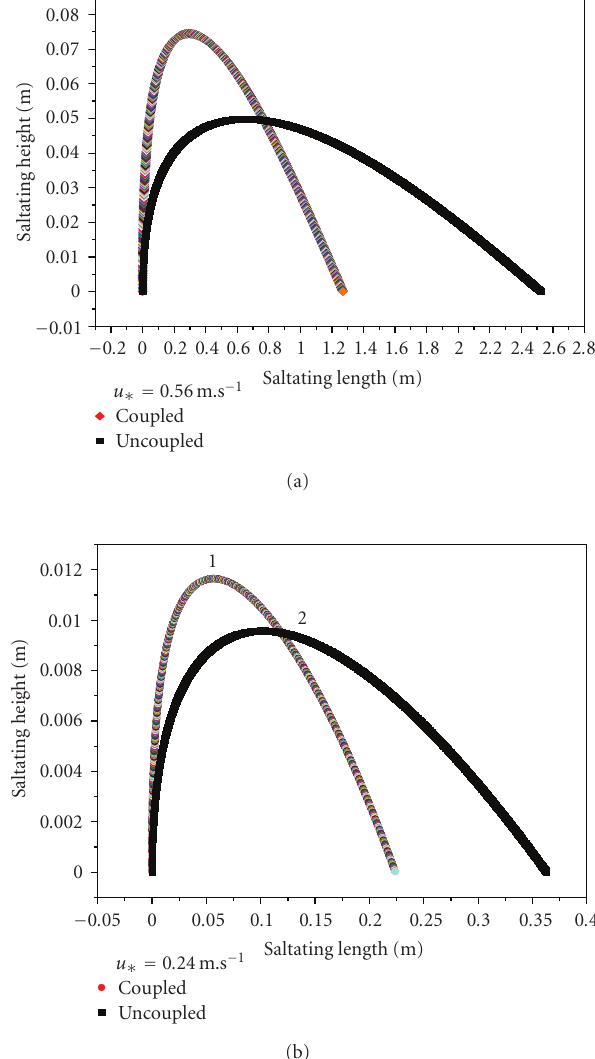
Figure 3: (a) A comparison of coupled and uncoupled particle trajectories for u ∗ = 0 . 56 m/s. (b) A comparison of coupled and uncoupled particle trajectories for u ∗ = 0 . 24